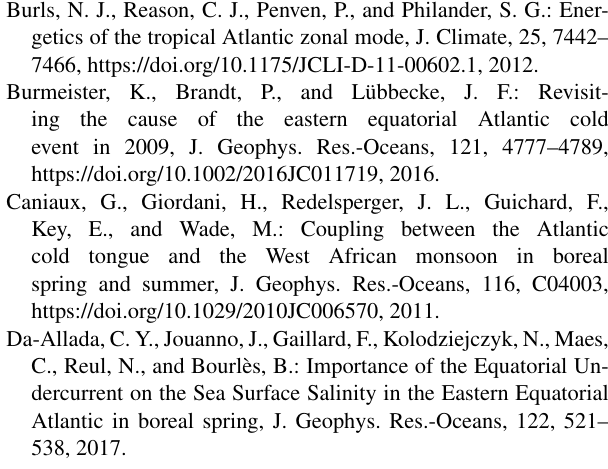
seasonal turbulent mixed-layer cooling is at its